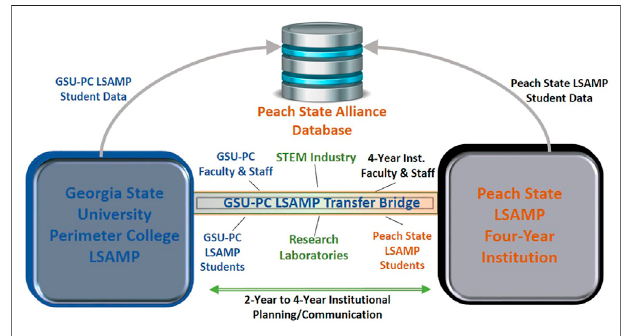
FIGURE 1 | Ideal GSU-PC transfer bridge